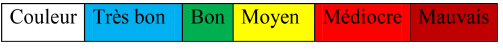
Tableau 2. Correspondance des valeurs des paramètres indicateurs de la qualité de